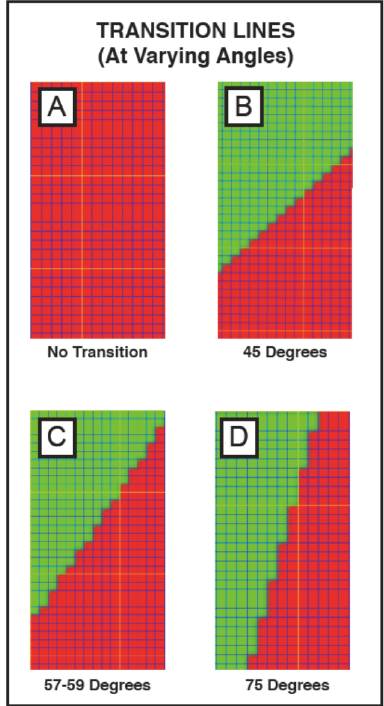
Figure 4. Transition line angles of knit samples: ( A ) No transition; ( B ) 45 degrees; ( C ) 57–59 degrees; ( D ) 75 degrees. Shima Seiki SDS-One Apex